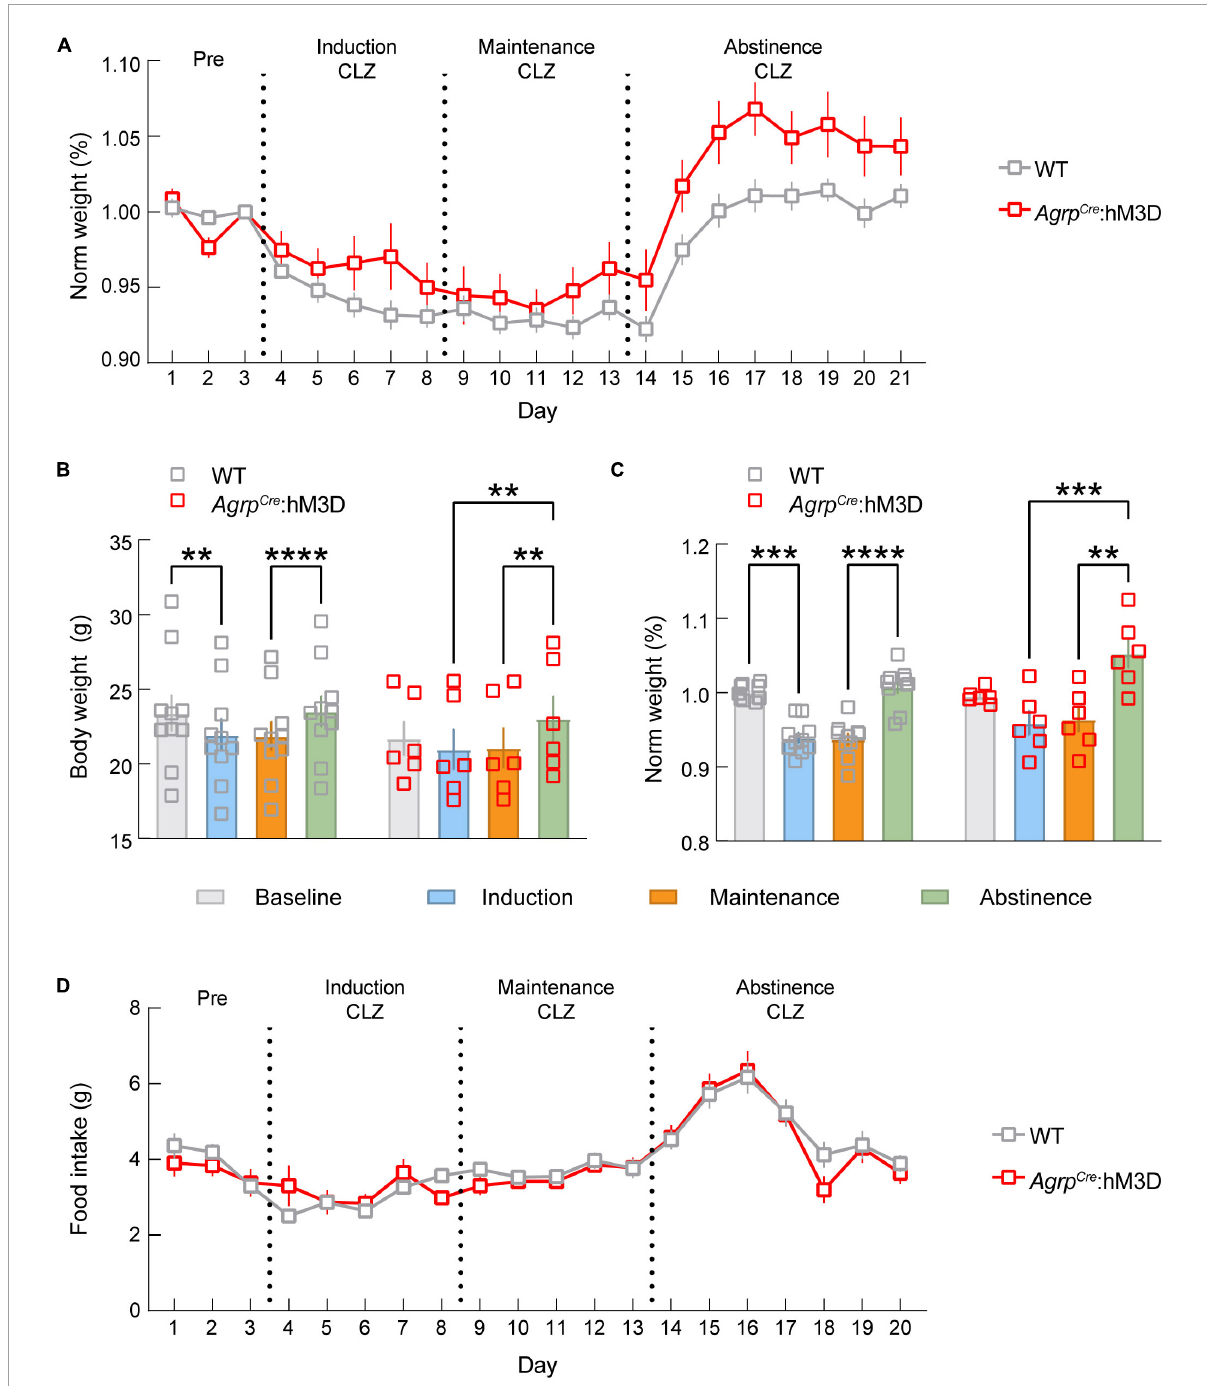
FIGURE5 ARC AGRP neuron activation attenuates morphine-induced weight loss. (A) Graph depicting the change in normalized body weight throughout the experiment between Agrp WT (WT; control) and Agrp Cre :hM3D groups. (B) Raw body weight data show that WT mice exhibit a significant drop in body weight during dependence that is not detected in the Agrp Cre :hM3D group. Both groups gain a significant amount of weight during abstinence. (C) Normalized body weight data show that WT mice exhibit a significant drop in body weight during dependence that is not detected in the Agrp Cre :hM3D group. Both groups gain a significant amount of weight during abstinence. (D) No significant differences in feeding behavior were observed throughout the duration of the experiment. See Supplementary Table 1 for details on statistical analyses. ** p < 0.01, *** p < 0.001, **** p <